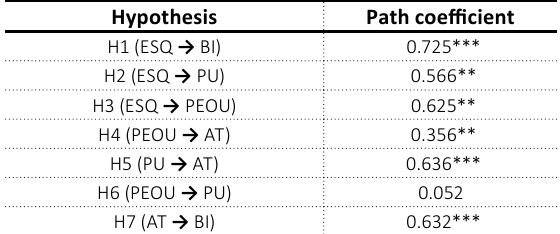
Table 4. Results of hypotheses testing Hypothesis